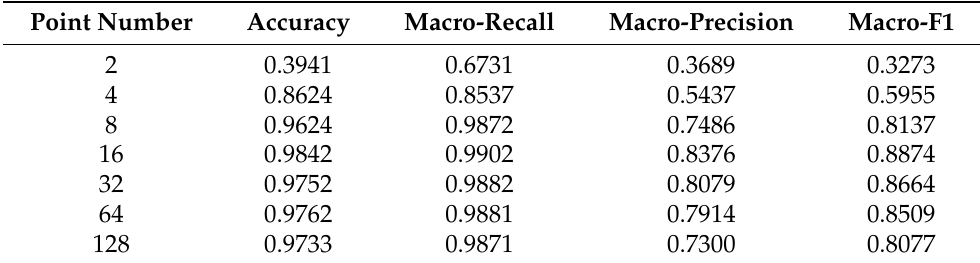
Table 1. The results of the sensitivity analysis of the number of input points of each building. Point